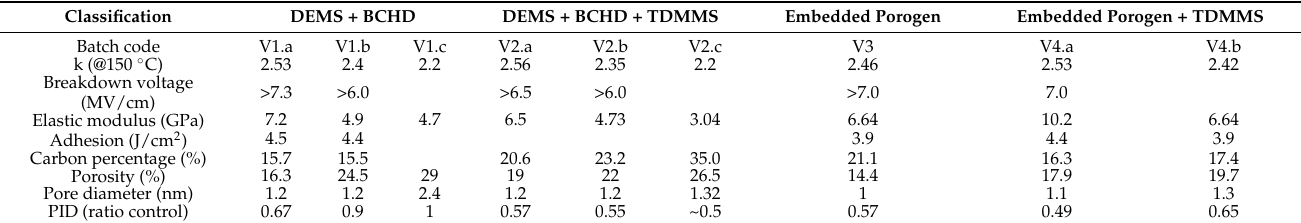
Table 5. Comparison among pULK ILDs fabricated with different precursors [27].